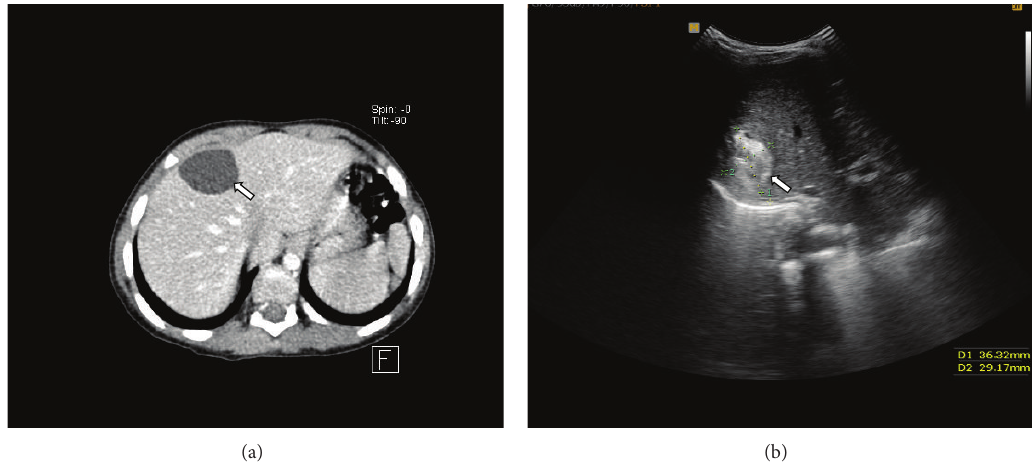
Figure 1: (a) CT shows a simple 3.7 × 2.8cm subcapsular liver cyst in median segment of left lobe (left arrow). (b) US shows a 3.6 × 3.2 cm heterogeneous lesion in right lobe of liver (left arrow).